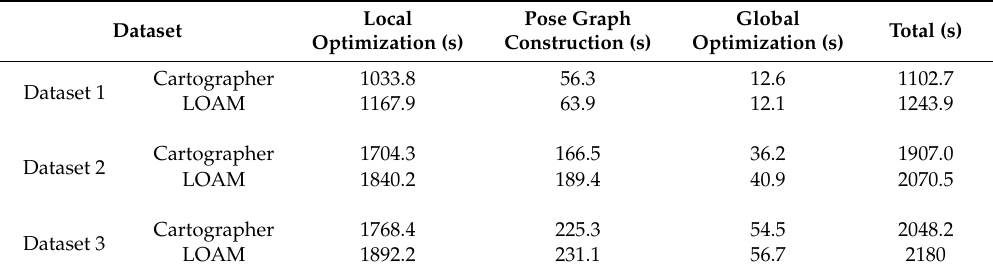
Table 5. The time cost of the proposed